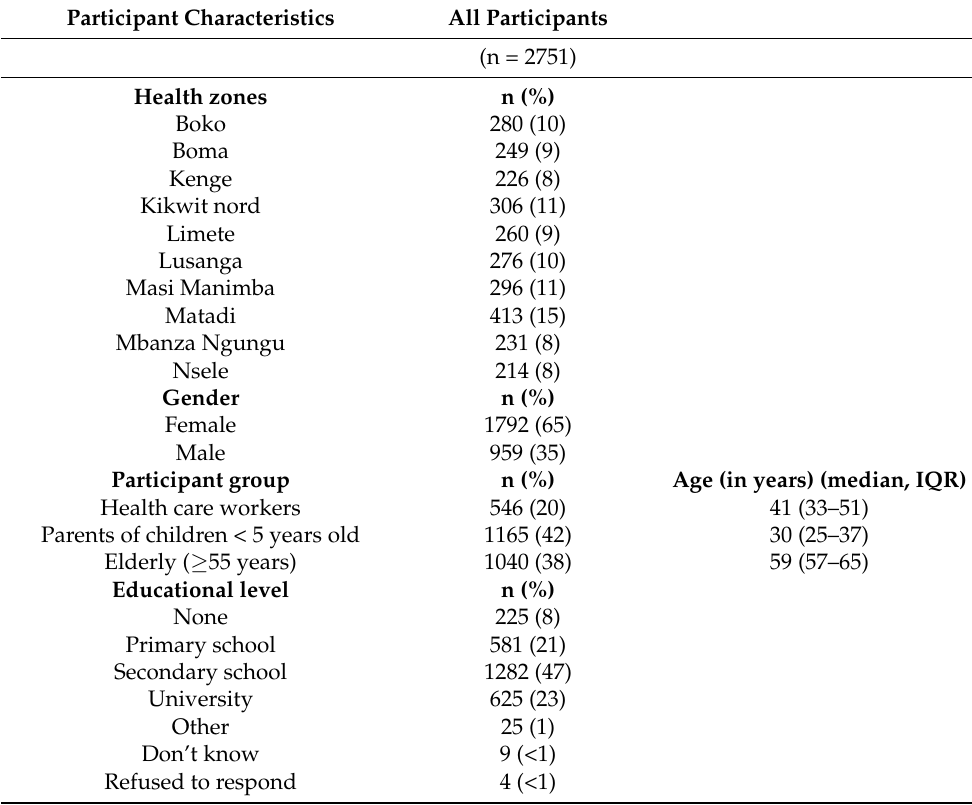
Table 1. Characteristics of participants included in the study (n =